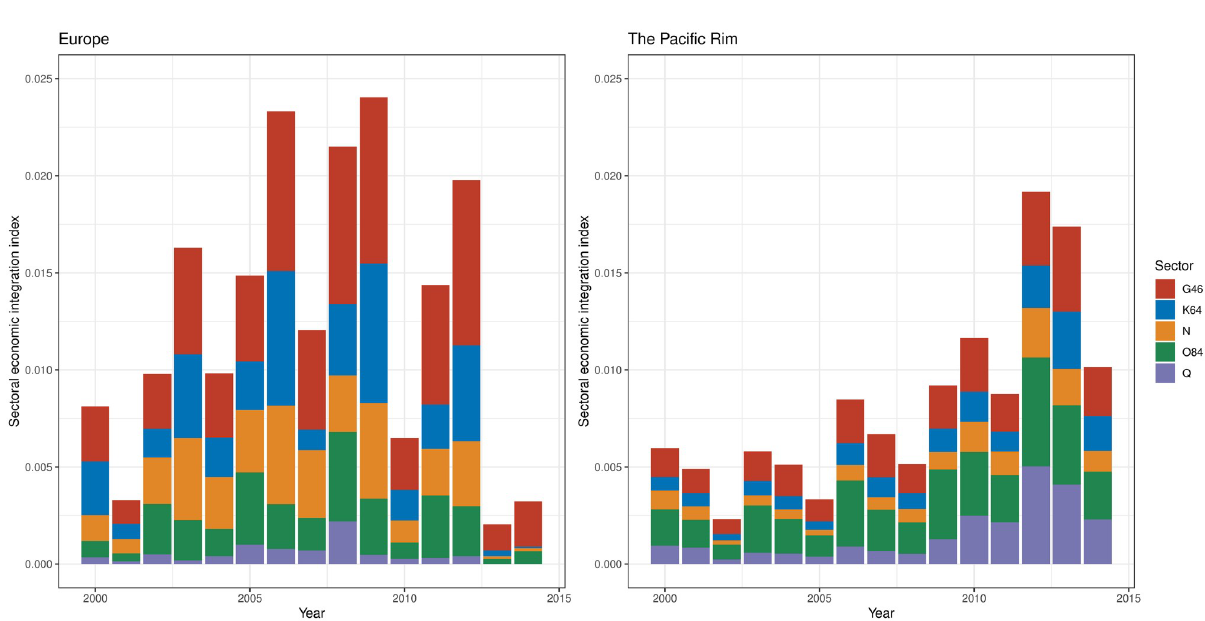
Fig 11. Sectoral economic integration index of other important sectors in two regional communities. G46: wholesale trade except motor vehicles and motorcycles; K64: financial service activities except for insurance and pension funding; N: administrative and support service activities; O84: public administration and defense, and compulsory social security; Q: human health and social work